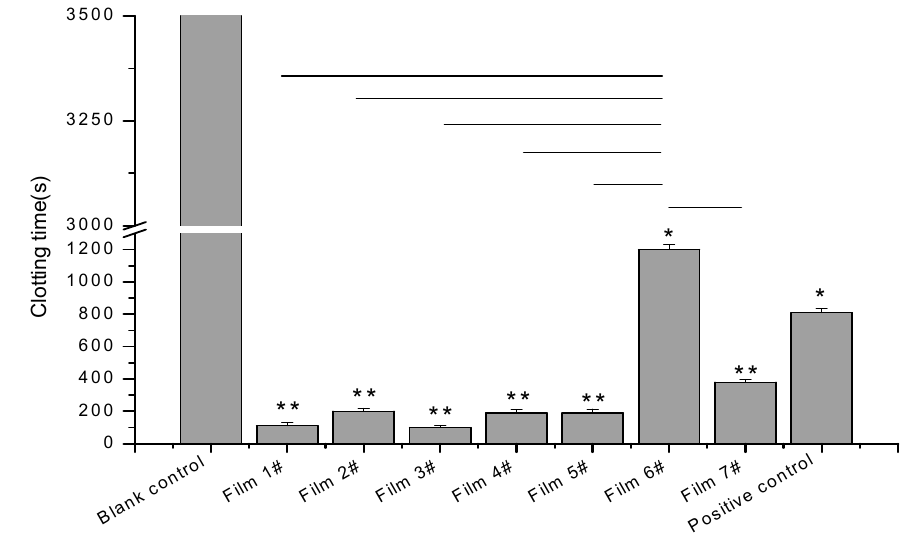
Figure 5. Clotting times of the composite films.